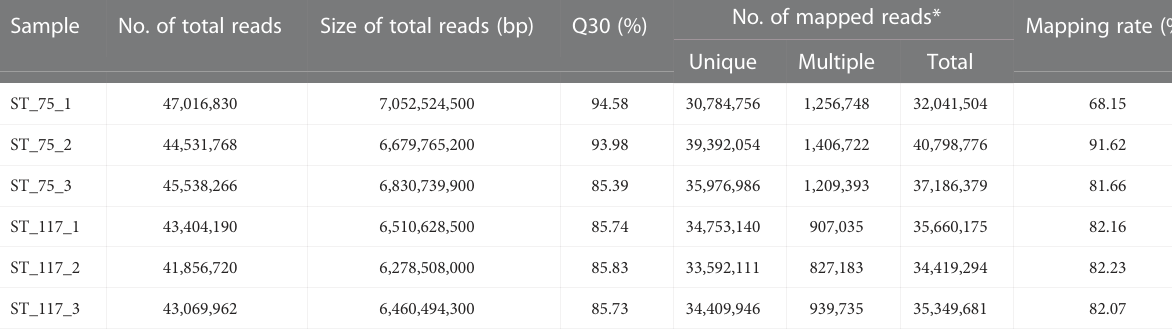
TABLE 1 Summary of the clean RNA-Seq reads for each treatment*.